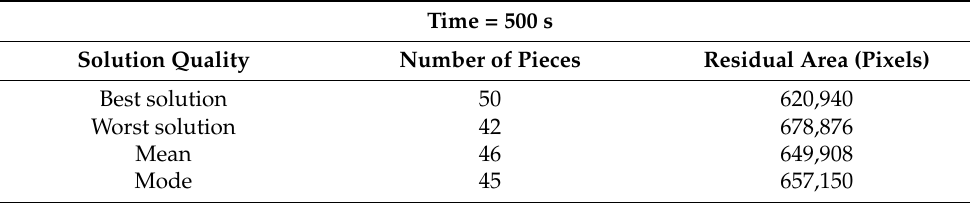
Table 1. ILS results of 500 experimental